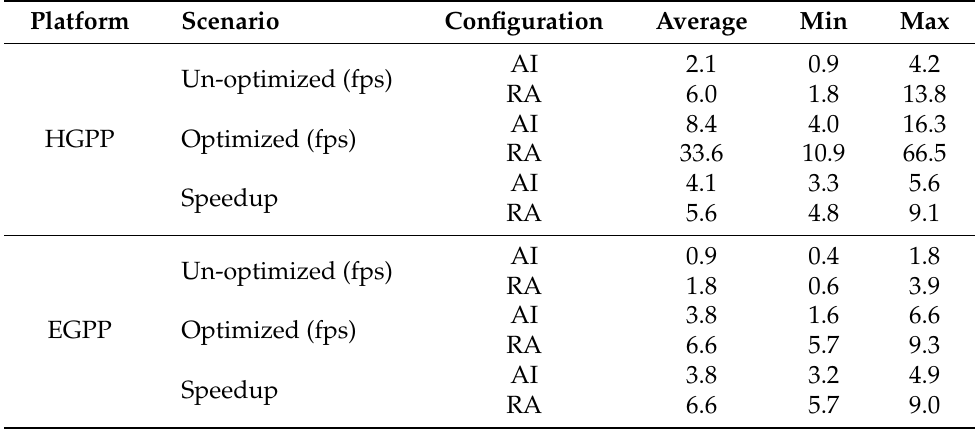
Table 10. Optimistic (max) and pessimistic (min) estimation of the performance achieved in future optimized solutions, resulting speedup for those scenarios is also